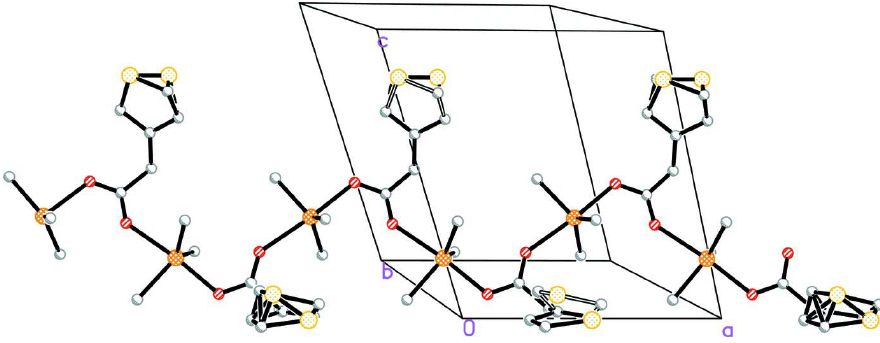
Figure 1 The molecular structure of (I), showing 50% probability displacement ellipsoids and the atom-numbering scheme. H atoms have been omitted for clarity.